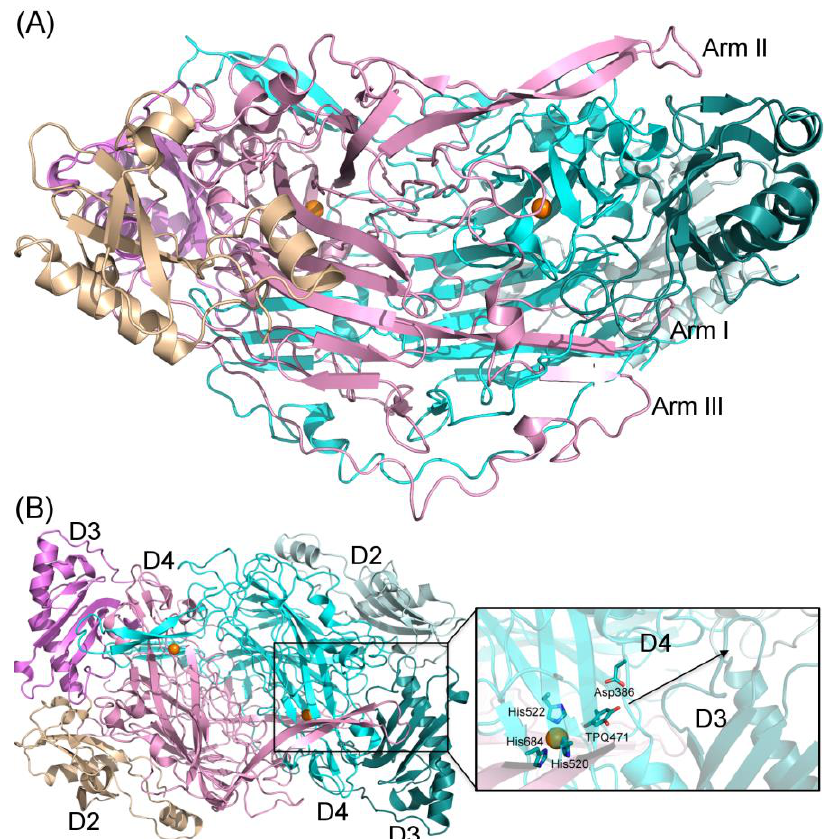
Figure 1. Structural features of human copper-containing amine oxidase (CAO) dimer. ( A ) Side view of the hVAP-1 dimer (PDB code 4BTY). Three long β -hairpin arms stabilize the tight dimer; ( B ) top view of hVAP-1 shows the D2, D3, and D4 domains in each monomer. In the deeply buried active site, the copper ion (orange sphere) is coordinated by the three conserved histidine residues (H520, H522, and H684 in hVAP-1). TPQ (TPQ471) is shown in o ff -copper, productive conformation, and the catalytic aspartate (Asp386) resides next to the quinone cofactor. Arm I (pink) extending from D4 of monomer B (pink) forms one wall of the active site channel. The black arrow depicts the direction from the catalytic site via the active site channel formed by the D3 and D4 domains to the surface of the protein.